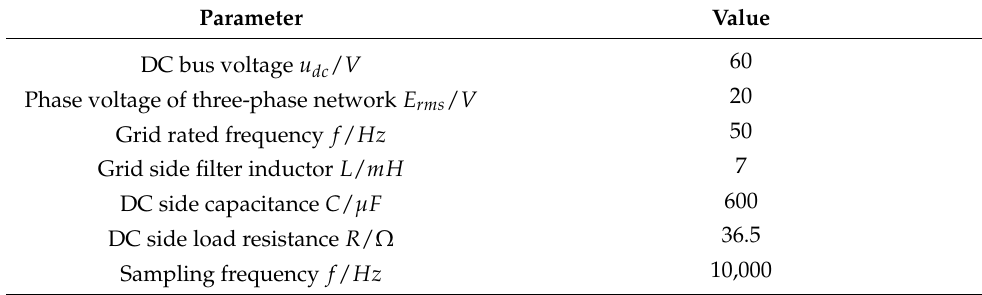
Table 1. The parameters of control